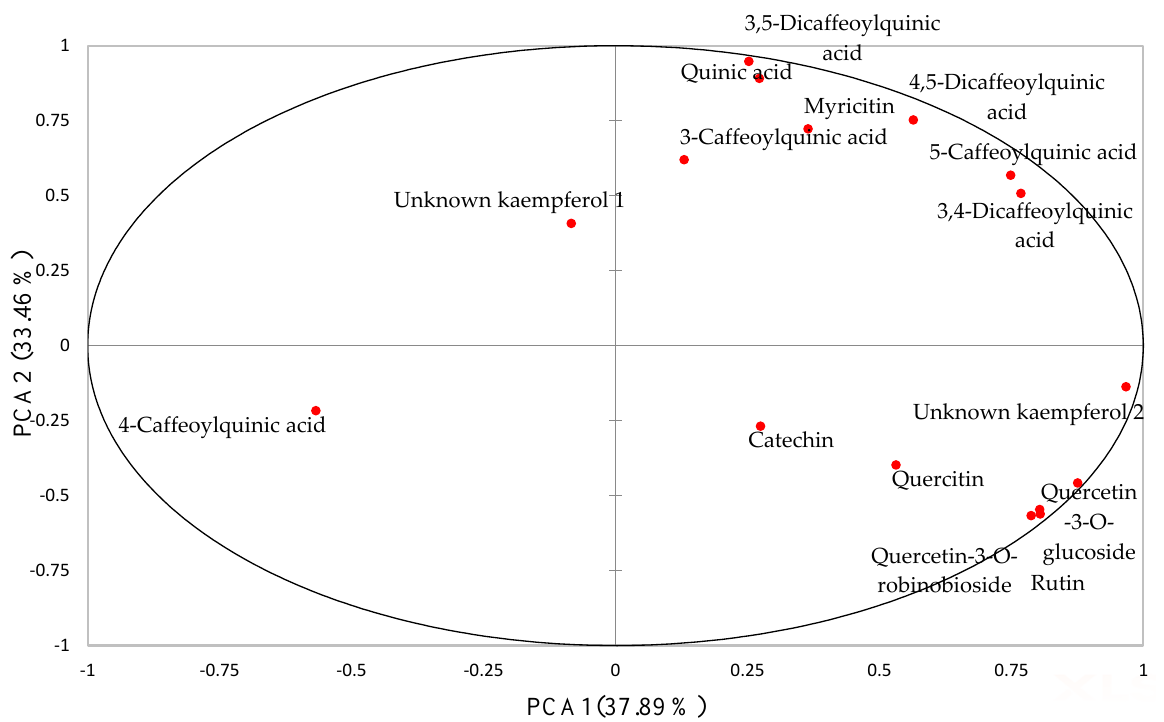
Figure 2. Principal component analysis (PCA) loadings of African pumpkin phenolic compound concentration.